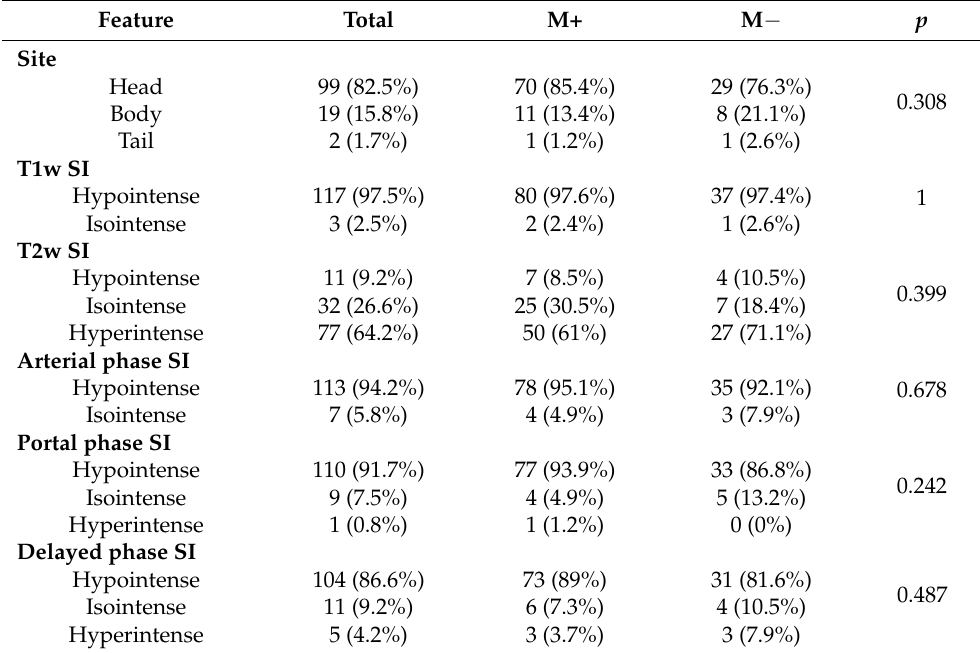
Table 2. Results of the Fisher’s exact test for comparison of conventional MR features; data are number of cases (%).